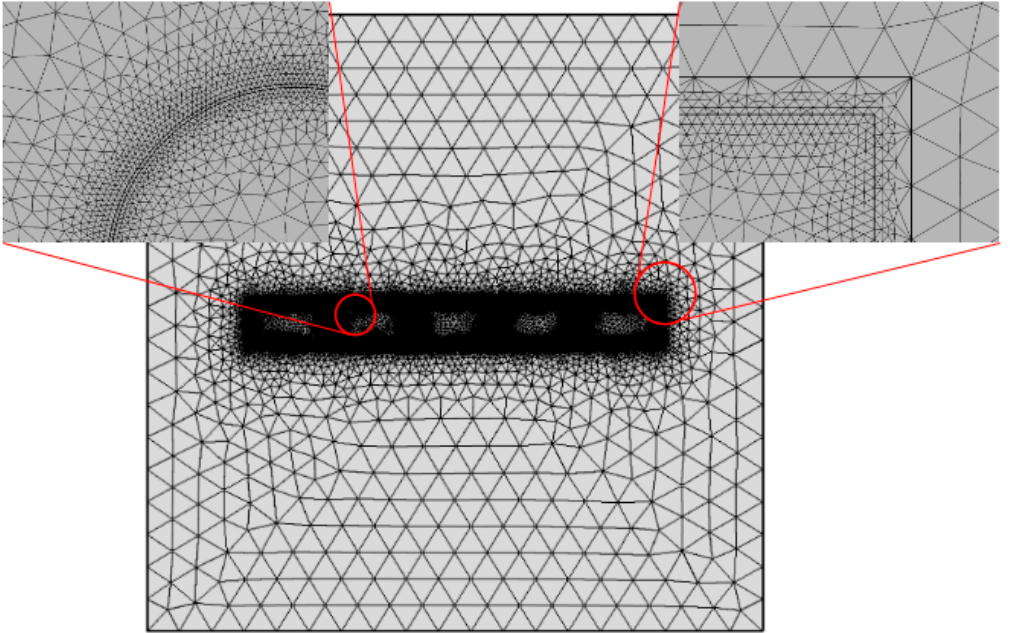
Figure 1. Dielectric model and finite element division of filamentous fungi.